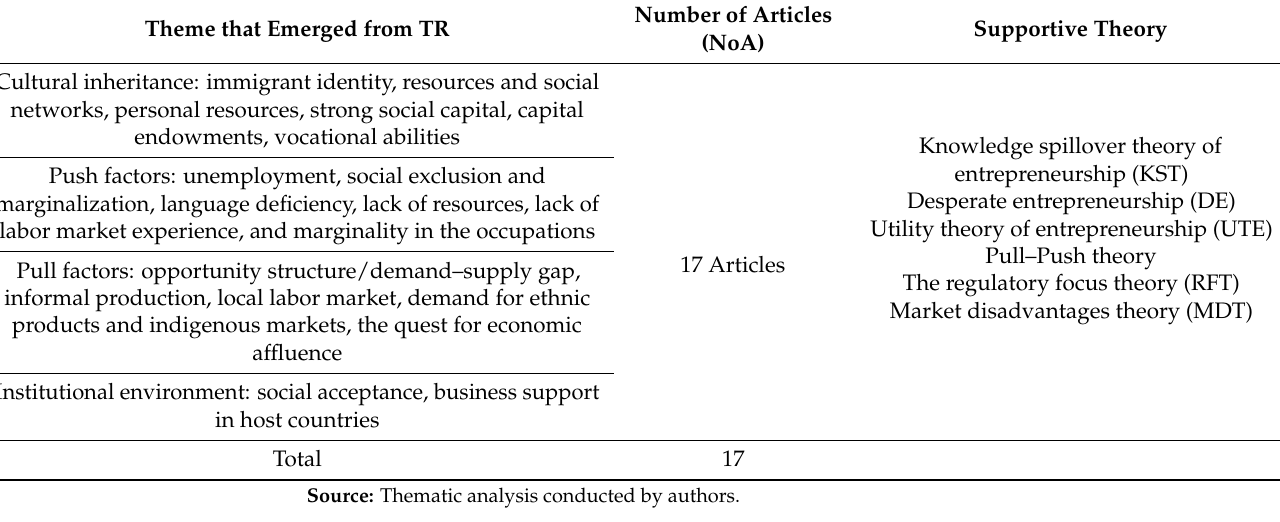
Table 2. Motivational factors for TE among immigrant entrepreneurs.